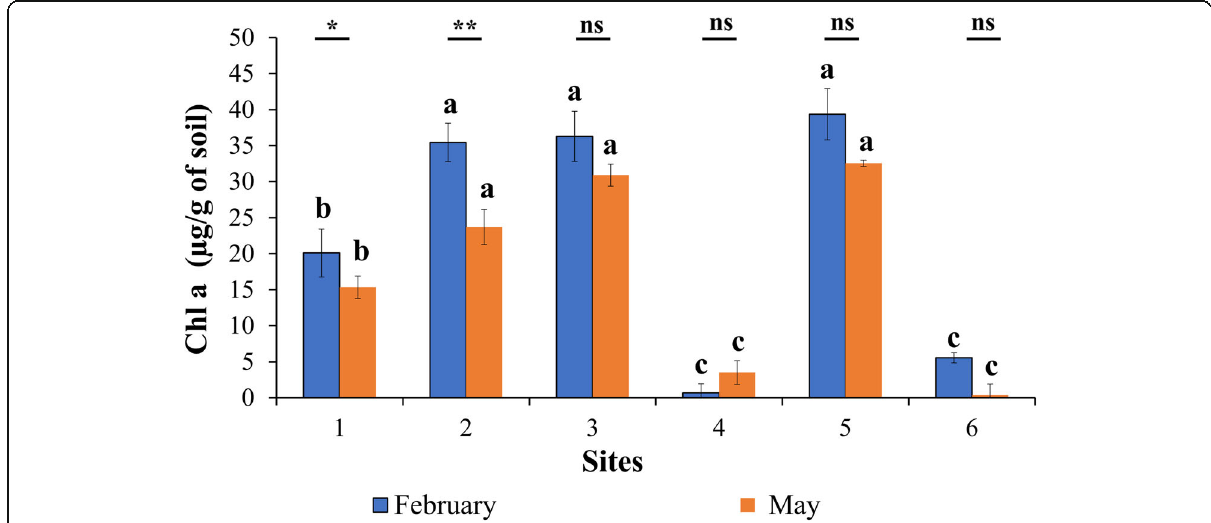
Fig. 2 Chlorophyll a concentration ( μ g/g soil) in soil microalgae. Data are means ± standard error ( n = 3). Different letters indicate significant differences ( p < 0.05 by Tukey ’ s HSD test) between sampled sites. NS: not significant; * p < 0.05 significant difference; *** p < 0.001